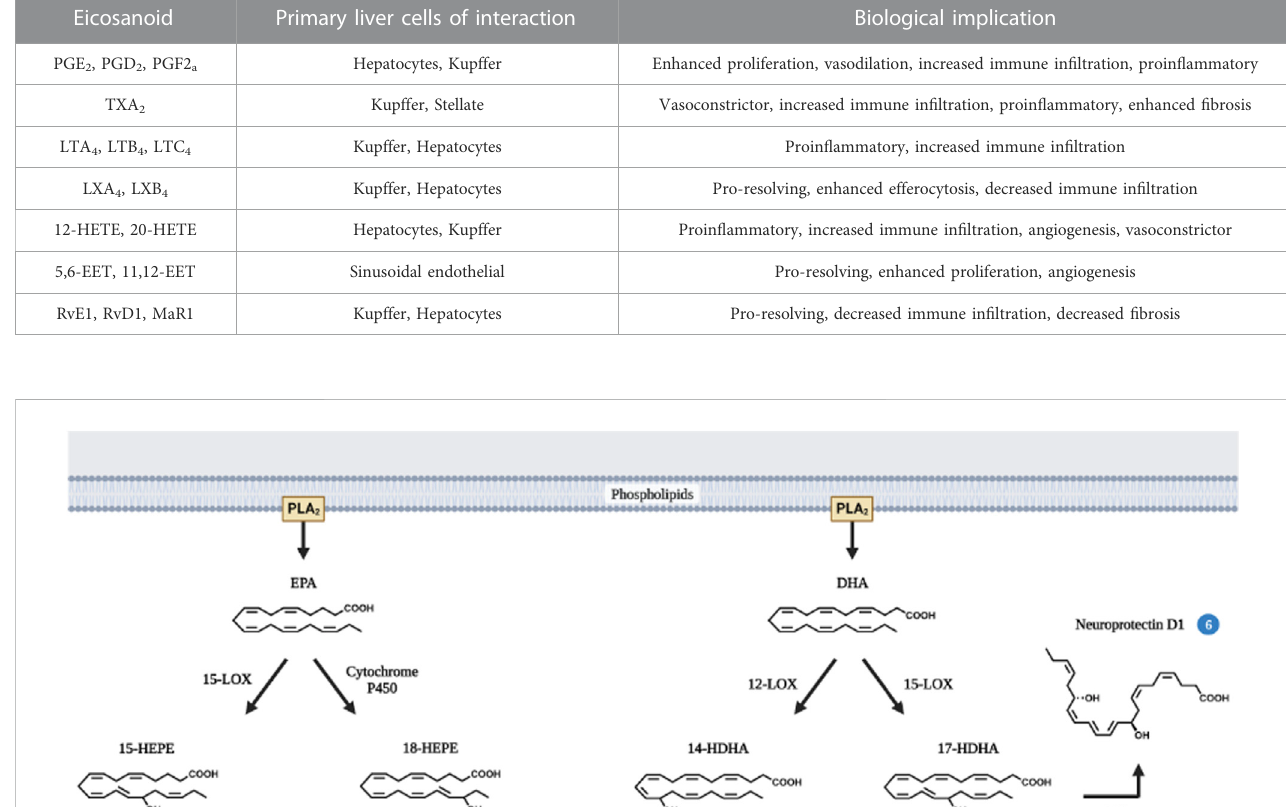
TABLE 1 Examples of Eicosanoid ’ s function in the liver.